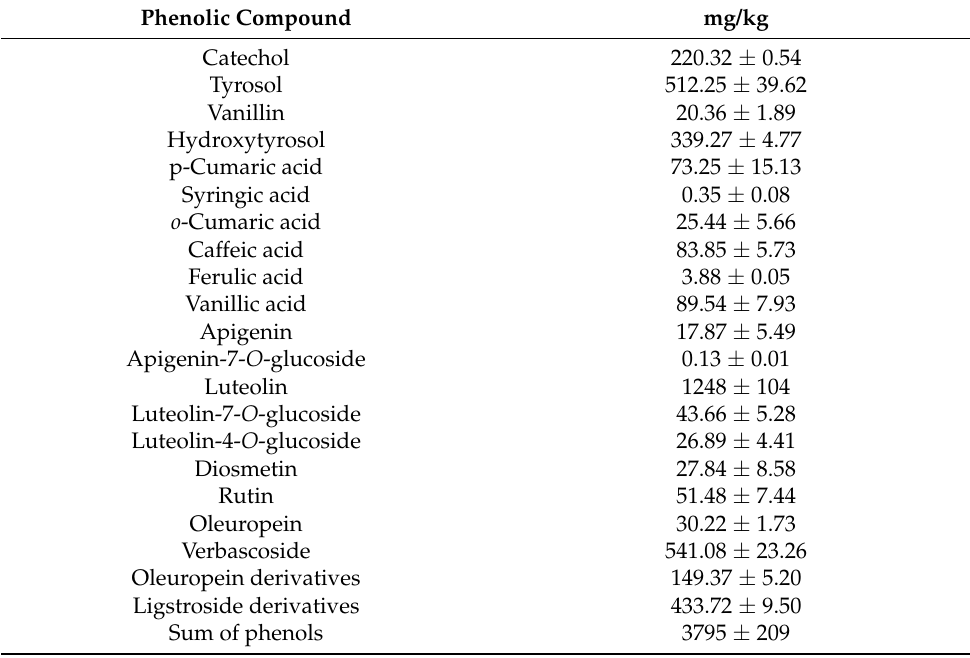
Table 6. Phenols content (mg/kg) in dried destoned virgin olive pomace (DDVOP) by liquid chromatography–tandem mass spectrometry (LC-MS/MS).